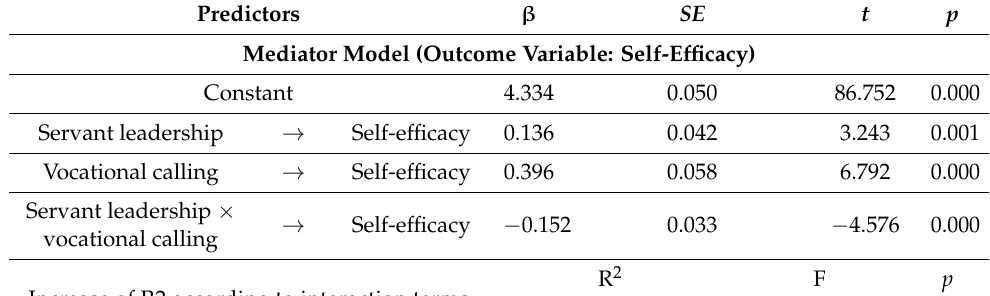
Table 4. Causal relationship between the concept of composition.